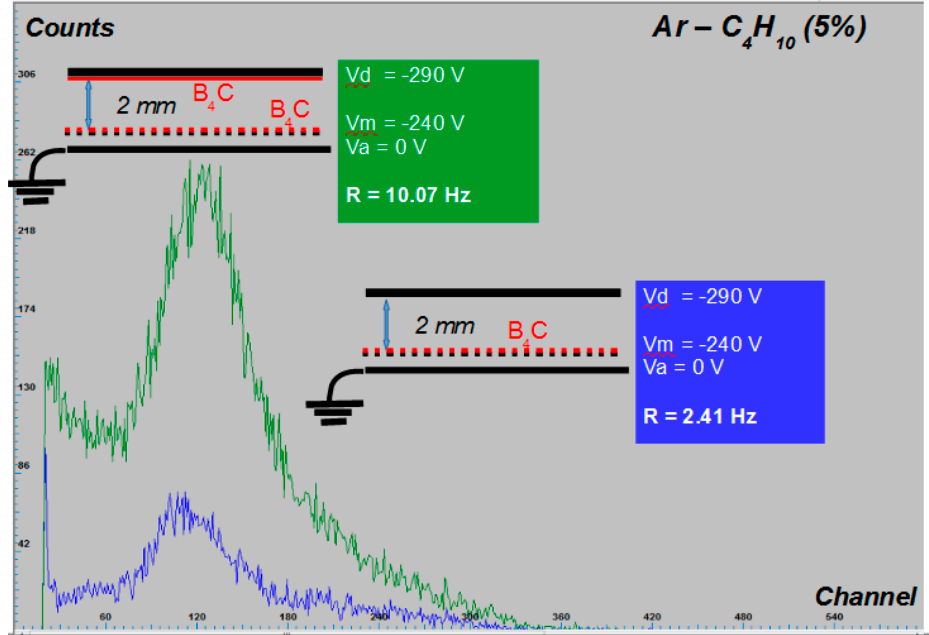
Figure 5 . Data measured during 3000 s for two runs with one-side coated aluminum end plate and without coated end plate, using a Microbulk Micromegas coated with 0.4- μ m 10 B 4 C and installed into a single detector prototype unit equipped with a 10 B 4 C one-side coated aluminum end plate (1.5 μ m thick).